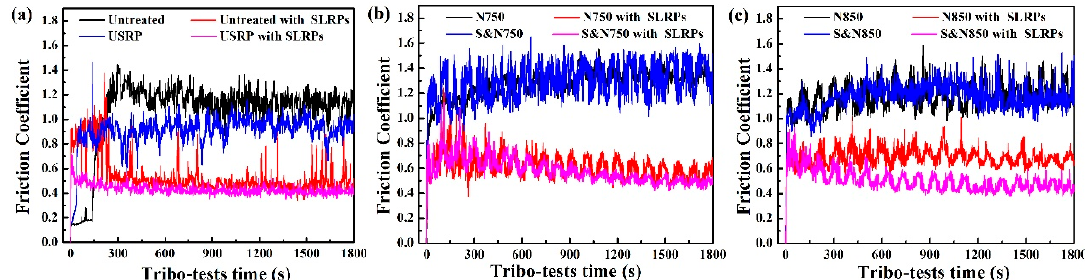
Figure 7. Friction coe ffi cients of the ( a ) untreated and USRP pre-treated, ( b ) N750 and S&750 and ( c ) N850 and S&850 Ti sliding against a SiO 2 ball with and without abrasive SLRPs.